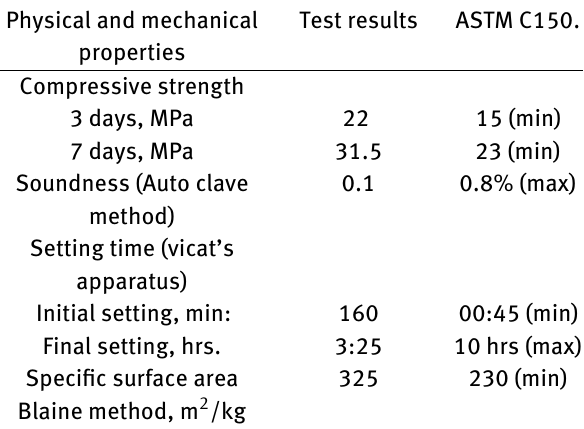
Table 2: Physical and mechanical properties and specification